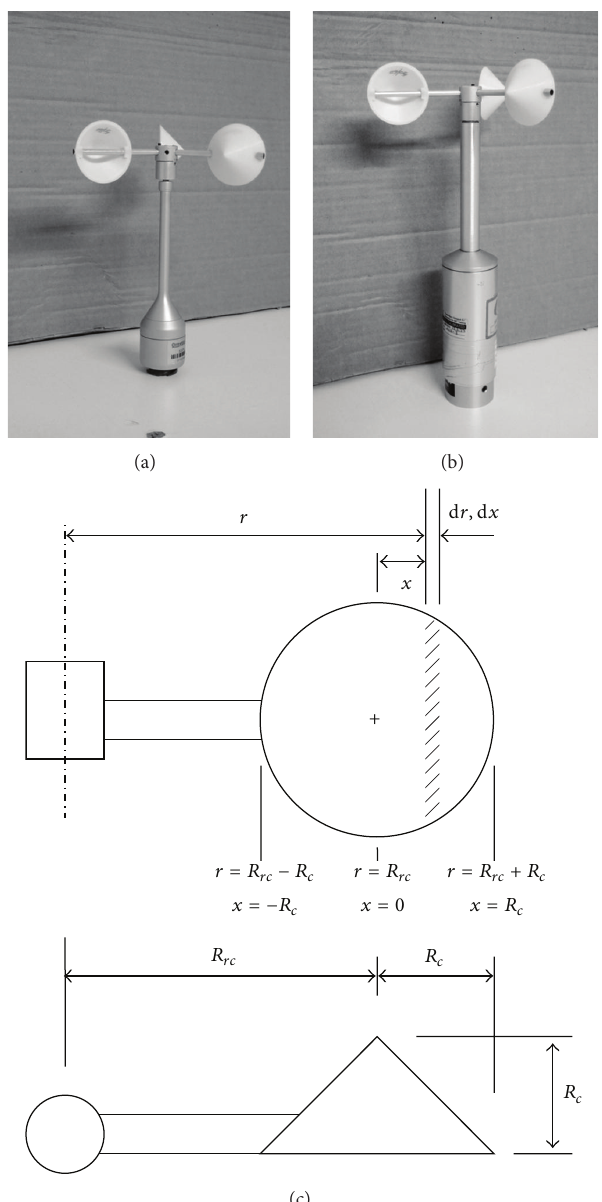
Figure 1: Anemometers used in the testing campaign related to the calibration results from Table 2, Climatronics 100075 (b) and Ornytion 107A (a). A sketch of the conical cups of the rotors tested is also included